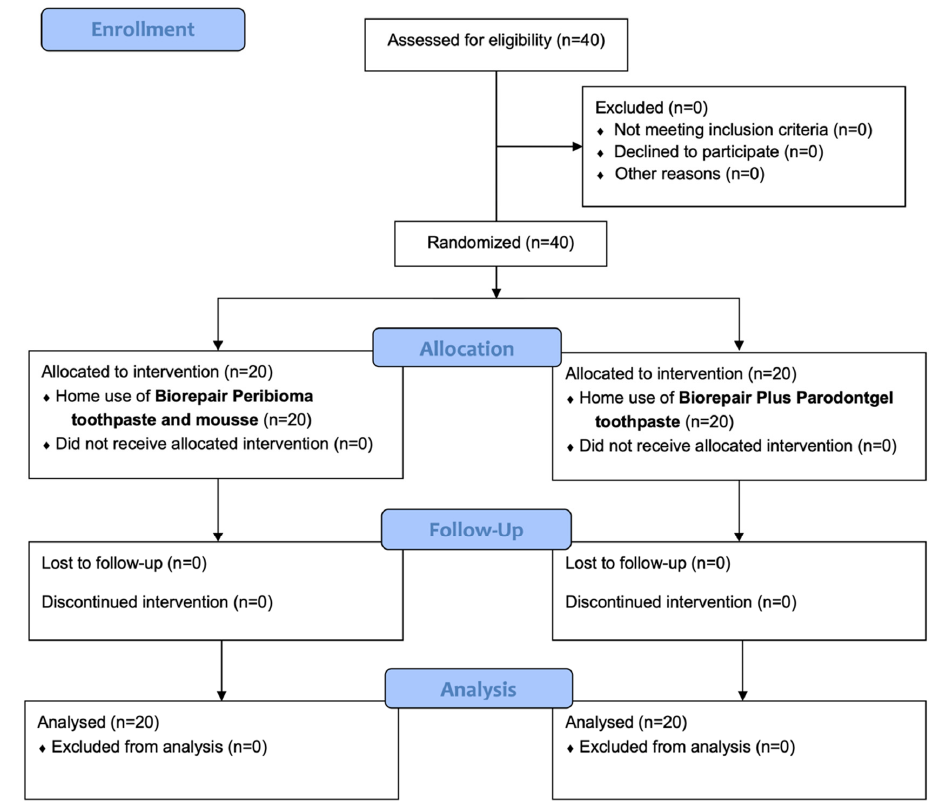
Figure 1. CONSORT flow-chart of the study. Table 3. Descriptive statistics of HbA1c measurements.